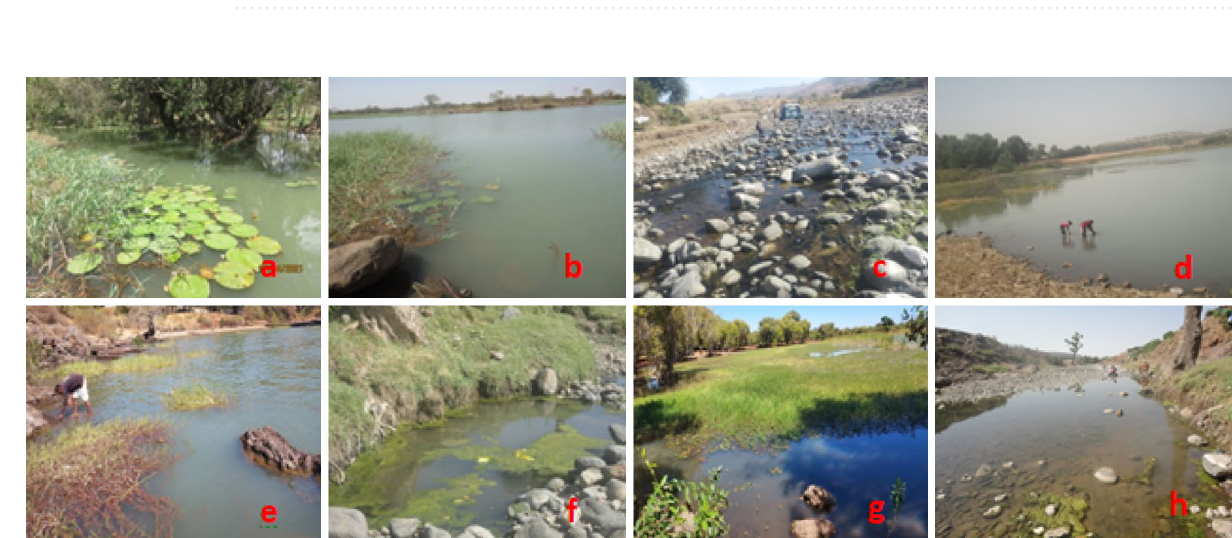
Table 1. Sampling points, GPS coordinates and other basic information of the snail collection sites.